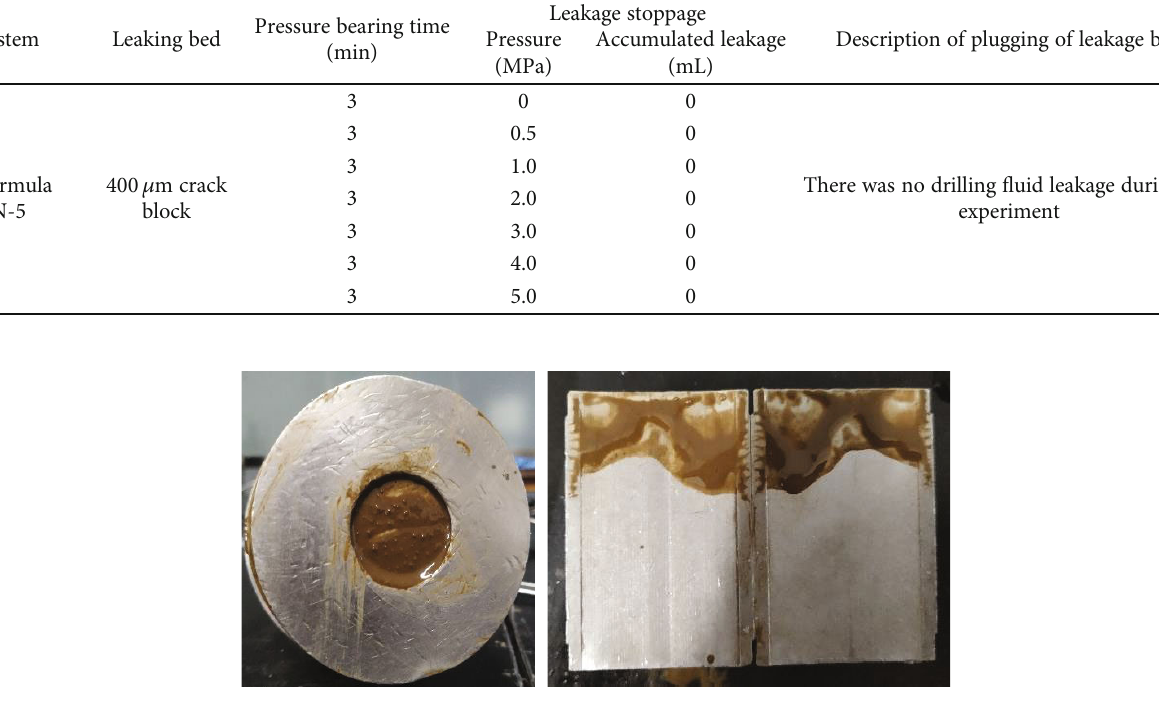
Figure 7: Fracture sealing evaluation results of strong plugging drilling fl uid. Evaluation of leakage and plugging performance of 400 μ m microfractures with Formula CN-5 drilling fl uid.